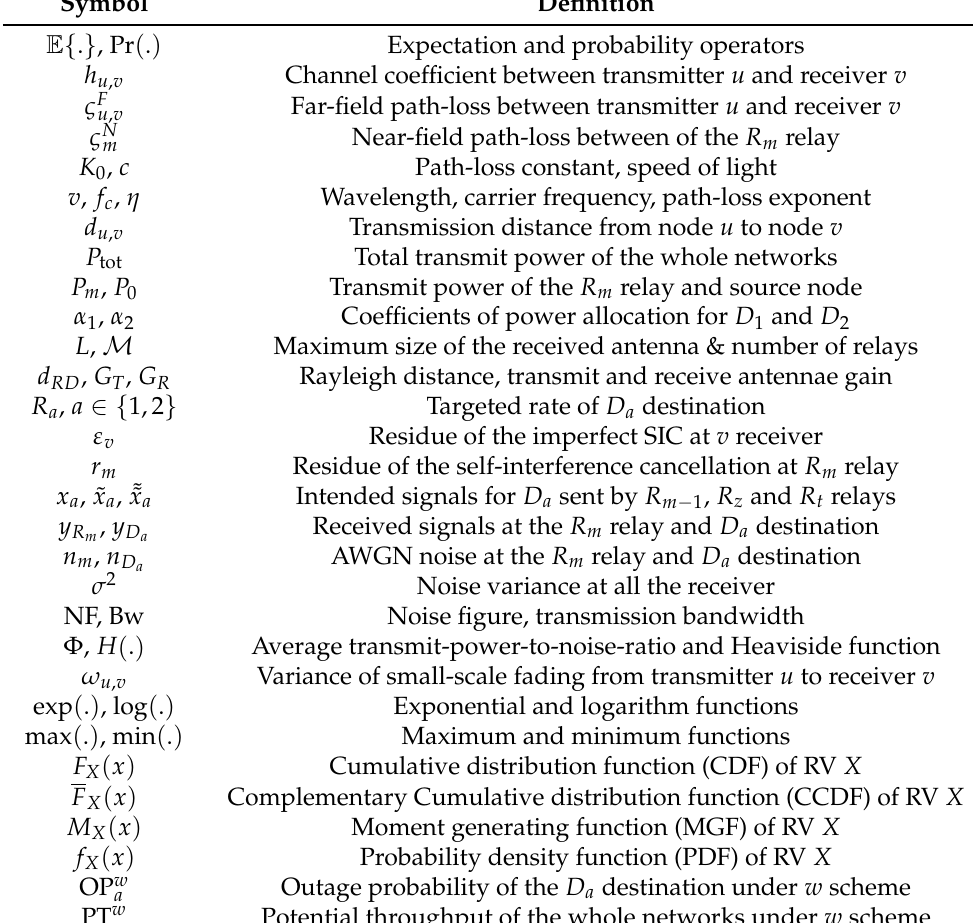
Table 1. Main notations and mathematical